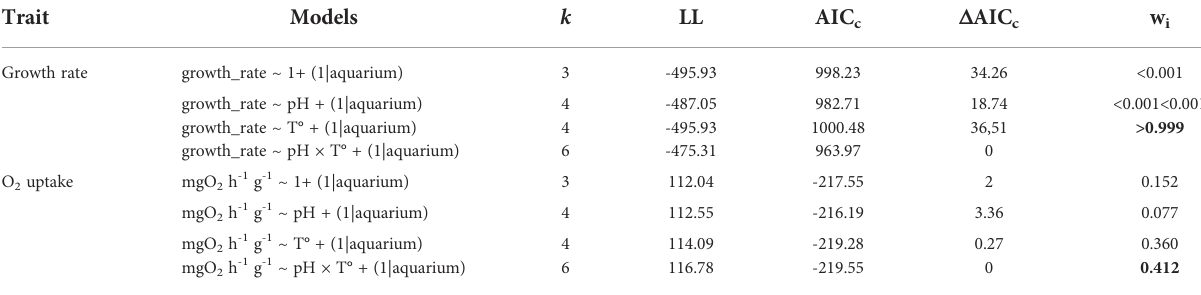
TABLE 2 Hierarchical general linear mixed models for physiological traits of Ameghinomya antiqua juvenile clams. Trait